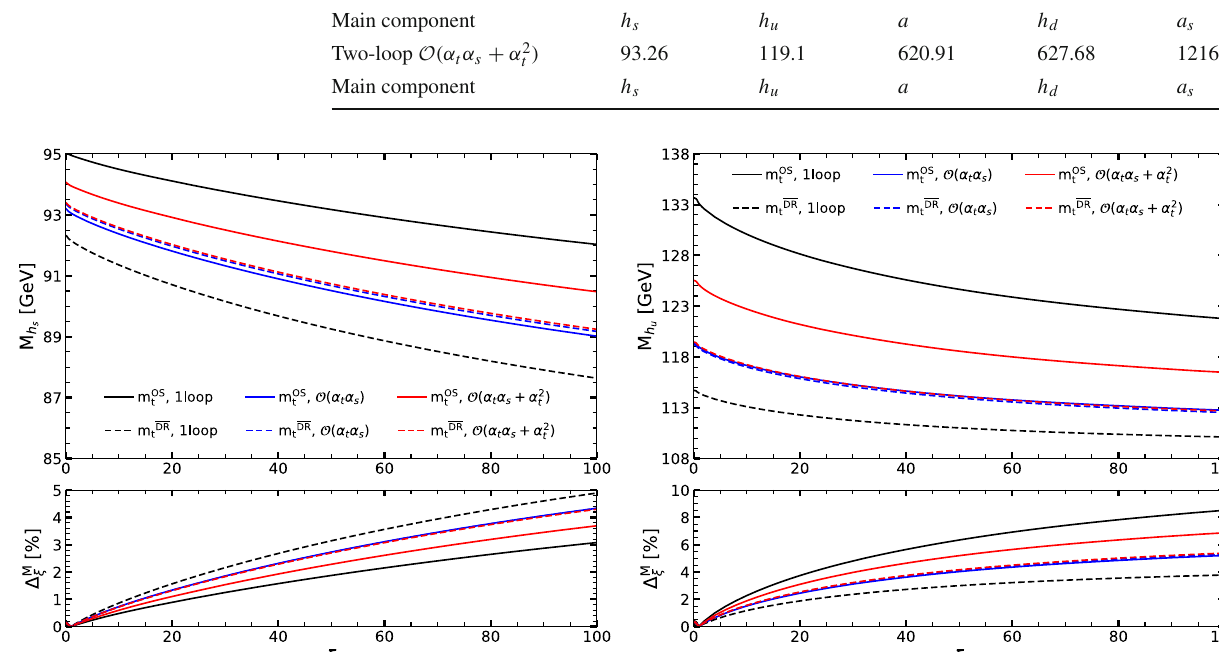
Table 3 P1: mass values in GeV and main components of the neutral Higgs bosons at tree level, one-loop level, two-loop α ) level and at two-loop O (α t s α + α 2 ) level obtained by O (α t s t using DR renormalization in the top/stop sector